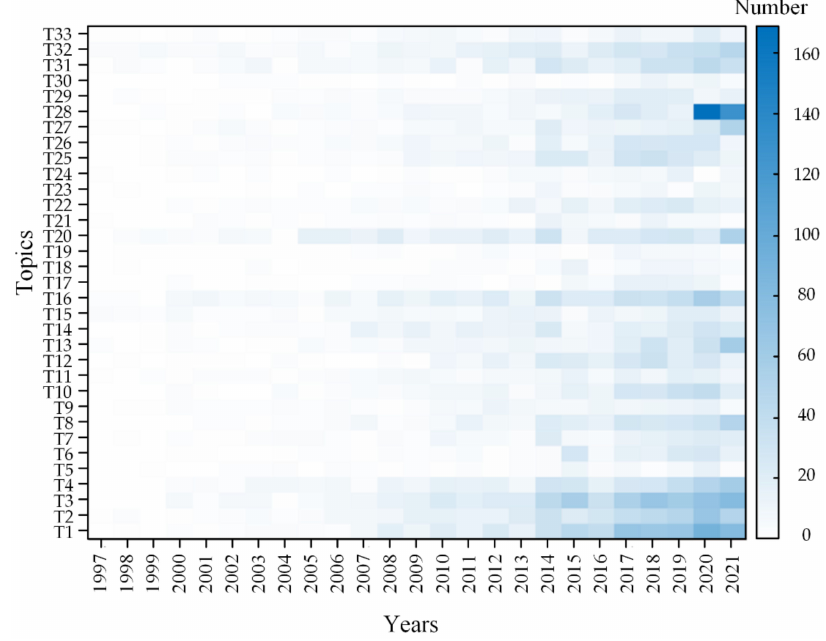
Figure 5. Heat map of published articles over the